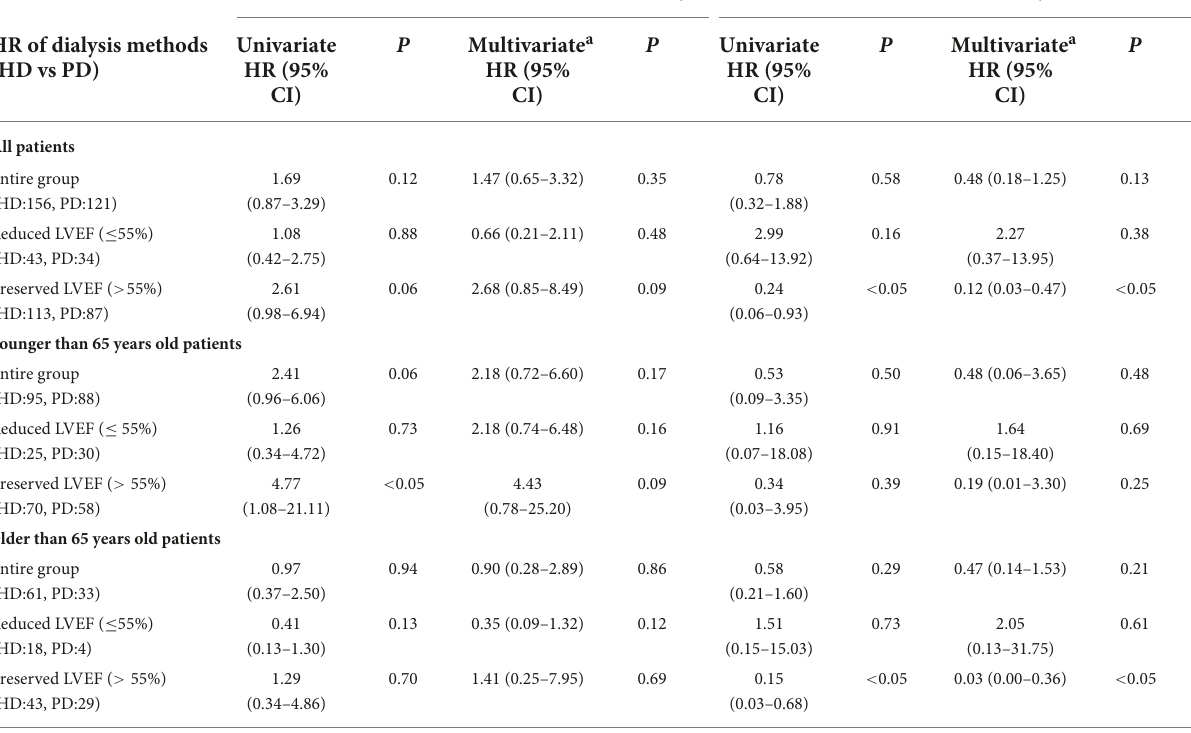
TABLE 7 Crude and adjusted hazard ratios for specific cause of mortality in competing risk model according to dialysis method. Cardiovascular and cerebrovascular mortality Infection